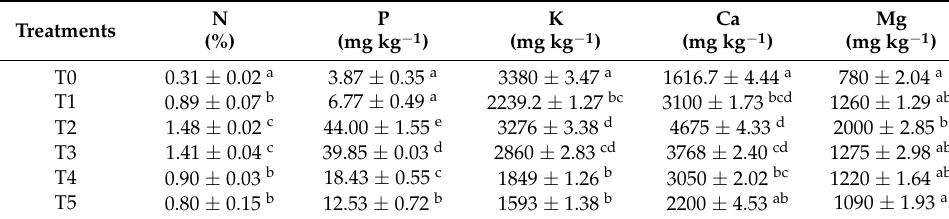
Table 11. Effects of RSRH biochar on N, P, K, Ca, and Mg concentrations at harvest (70 DAT).